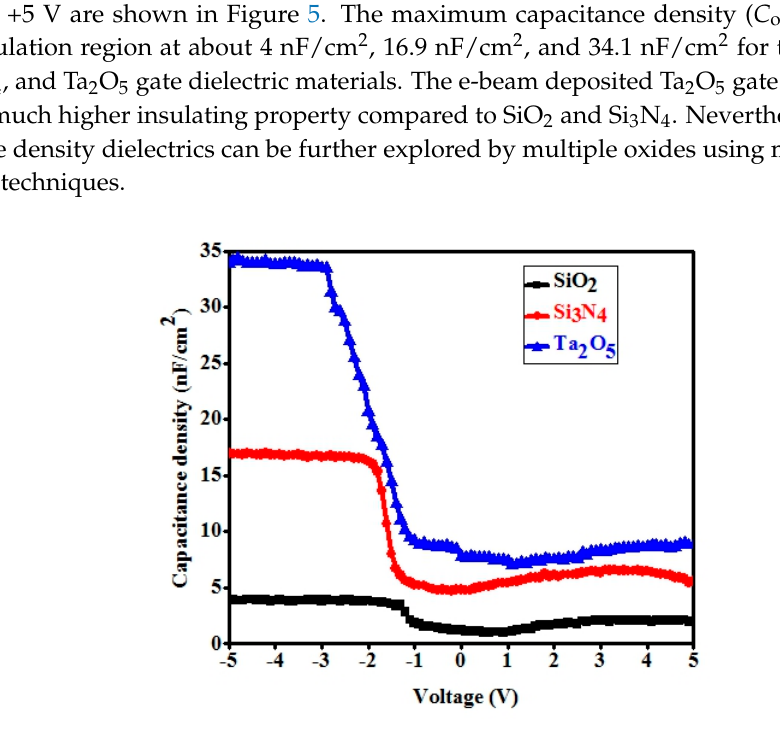
Figure 4. Atomic force microscopy (AFM) image of the e-beam deposited SiO 2 film on indium tin oxide (ITO) glass substrate.